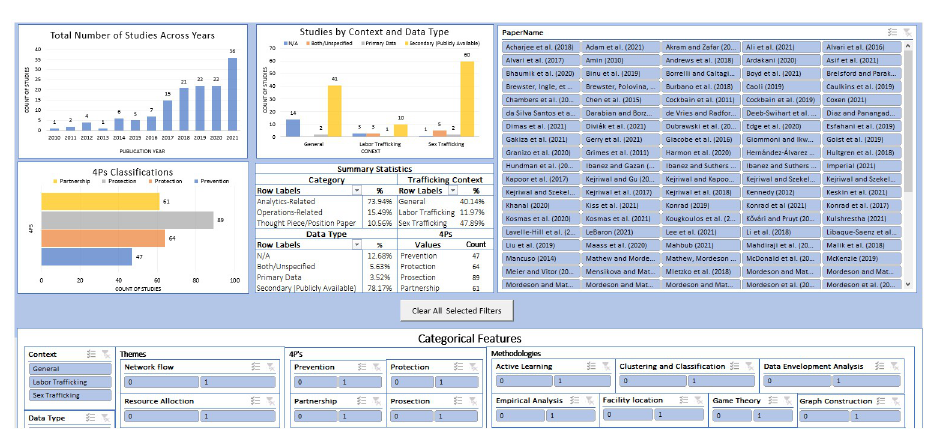
Fig 9. A screenshot of the spreadsheet tool created for closer examination of the set of 142 studies.